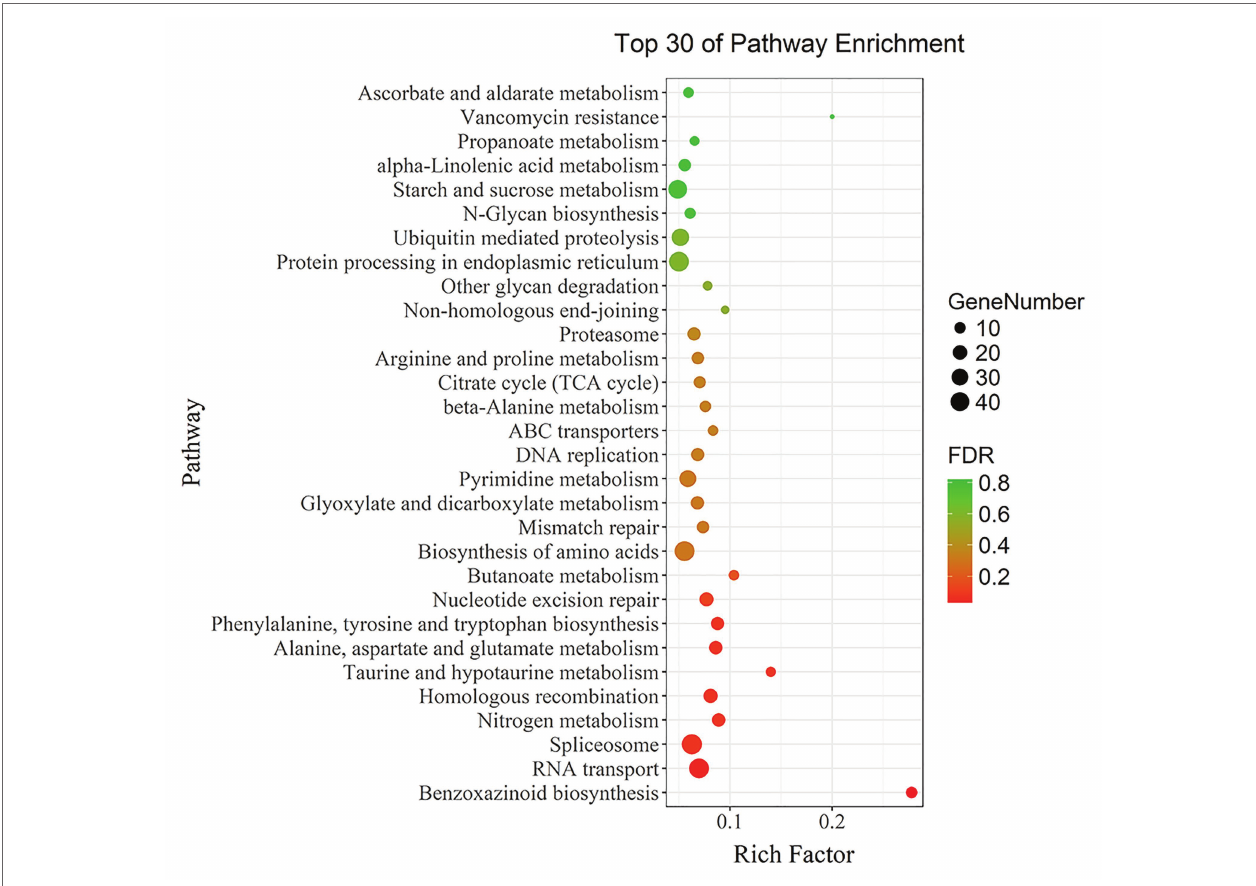
FIGURE 6 | KEGG functional enrichment analysis of differentially expressed genes. Each point in the graph represents a pathway. The size of the spot represents the number of differentially expressed genes enriched in the pathway. The color of the point represents the significance of enrichment, where the red color represents a significantly enriched pathway.